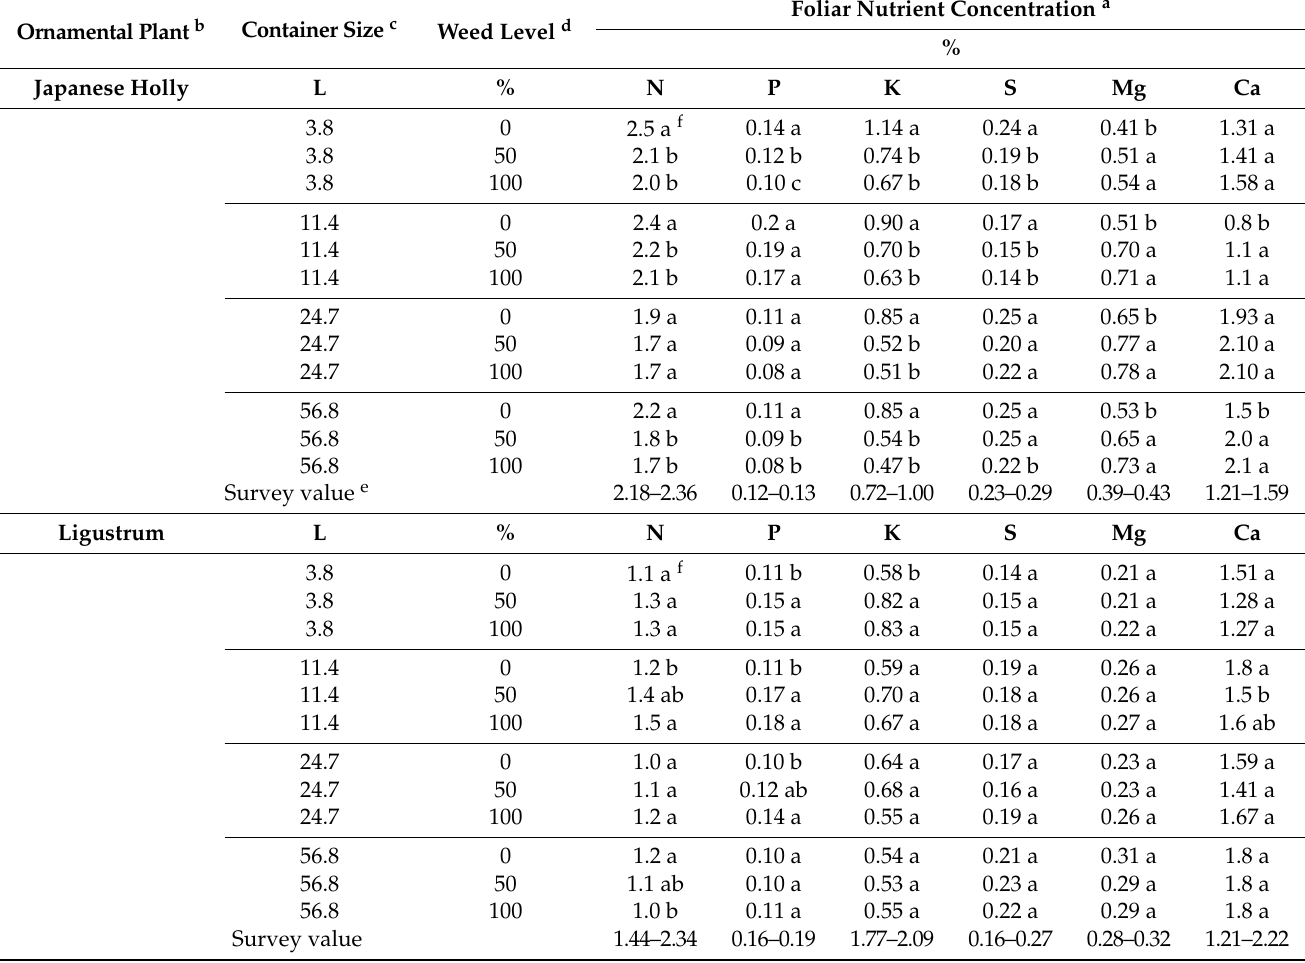
Table 3. Foliar nutrient concentration of Japanese holly grown in 3.8 L, 11.4 L, 24.7 L, and 56.8 L containers at 0%, 50%, and 100% weed coverage